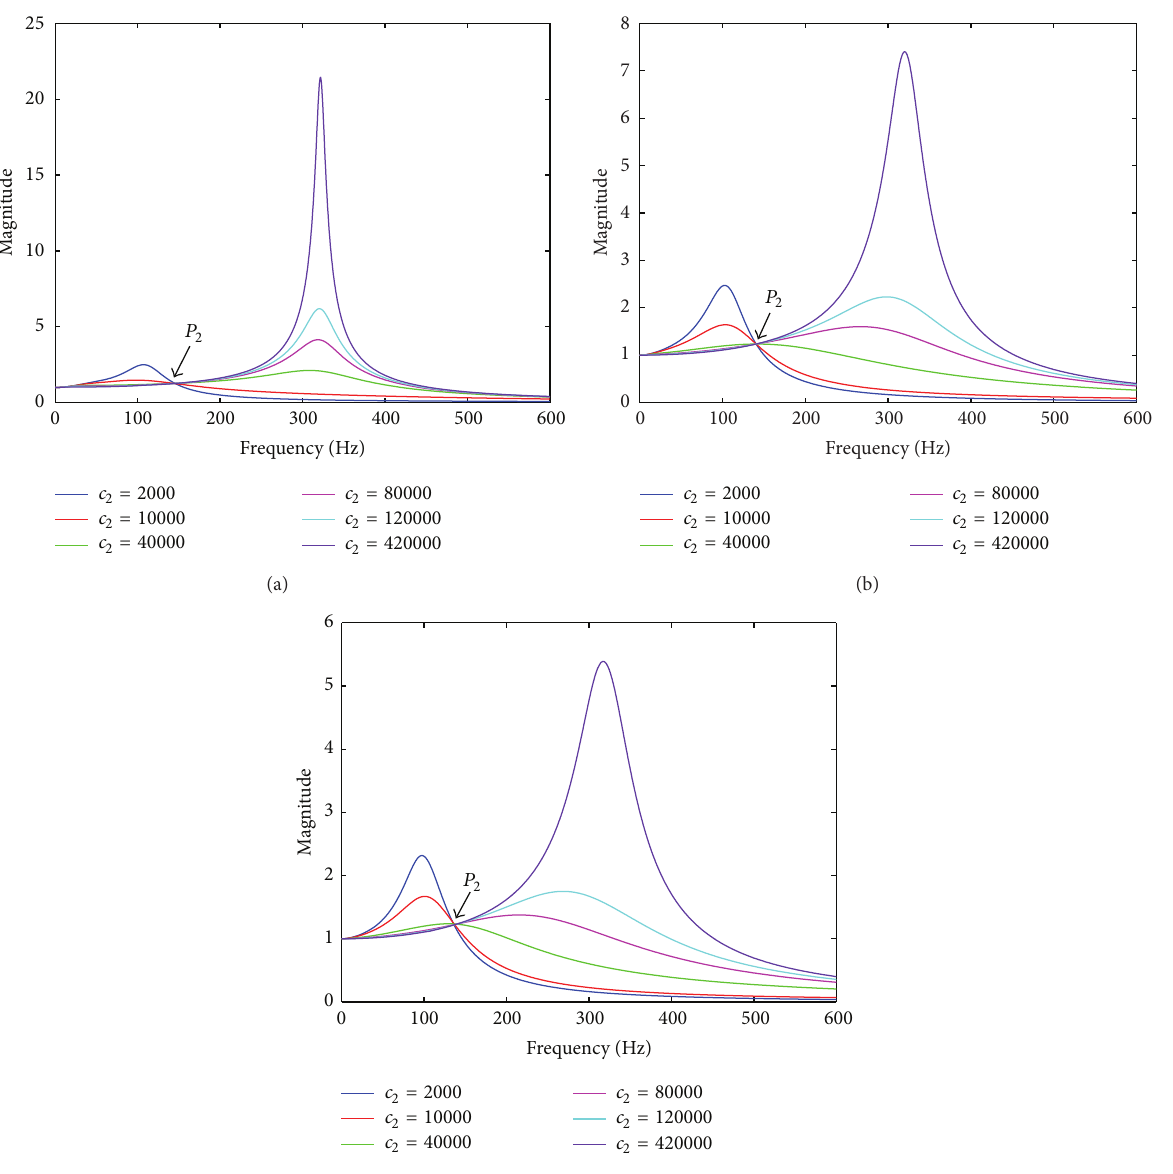
Figure 26: Absolute displacement transmissibility curves of CM under 5.07 mm FDE cases. (a) 𝑛 1 = 1.5 ; (b) 𝑛 1 = 1 ; (c) 𝑛 1 = 0.85 .